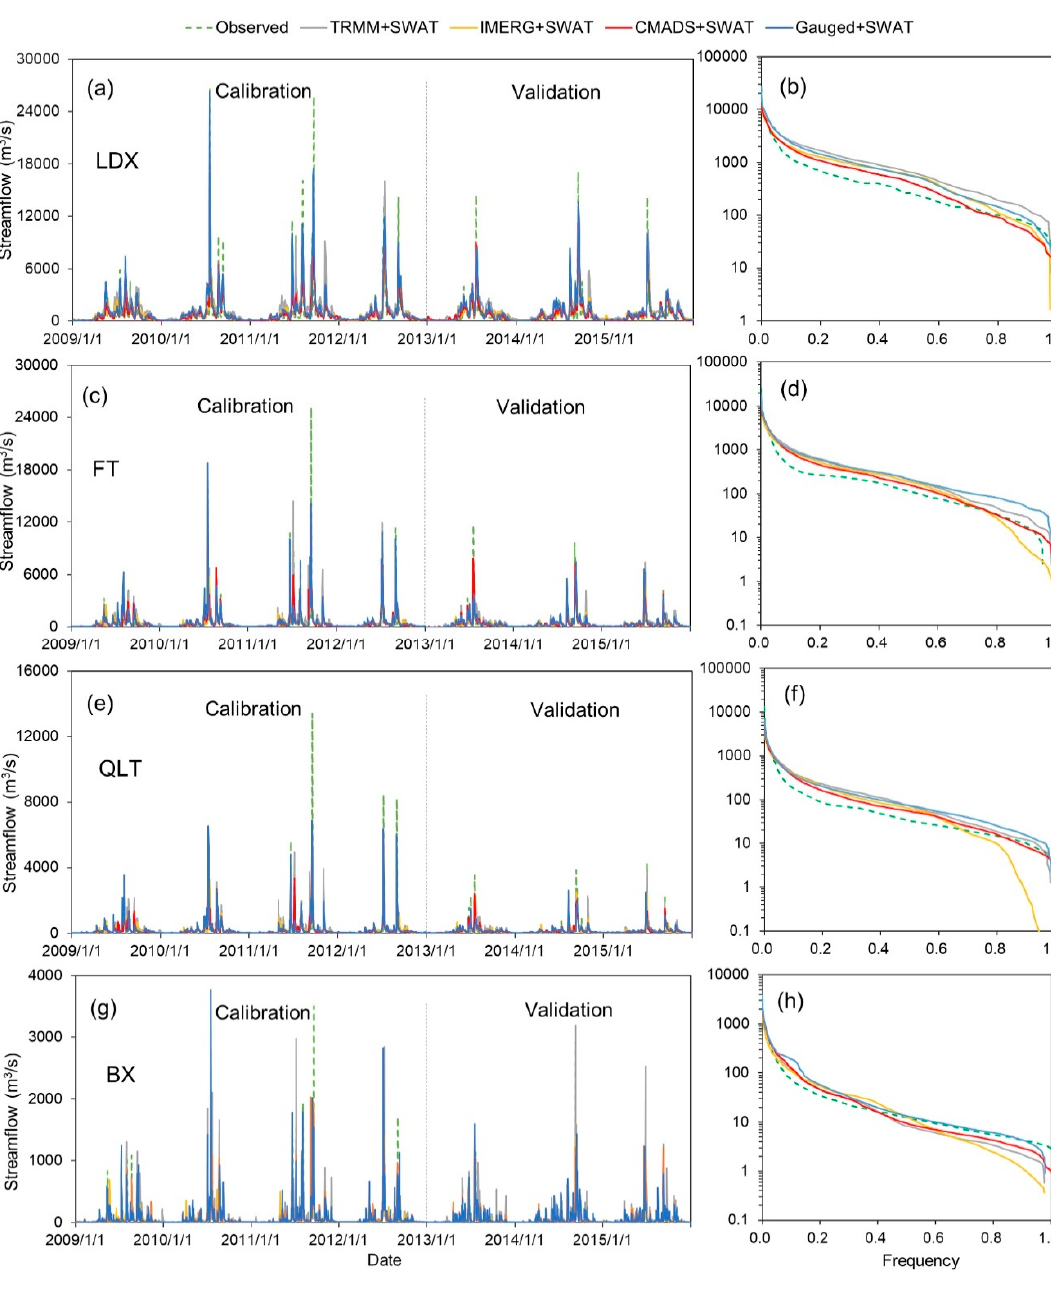
Figure 5. The hydrograph and streamflow frequency curve of the daily streamflow in the calibration and validation periods. ( a , b ) Luoduxi (LDX); ( c , d ) Fengtan (FT); ( e , f ) Qilituo (QLT); ( g , h ) Bixi (BX).